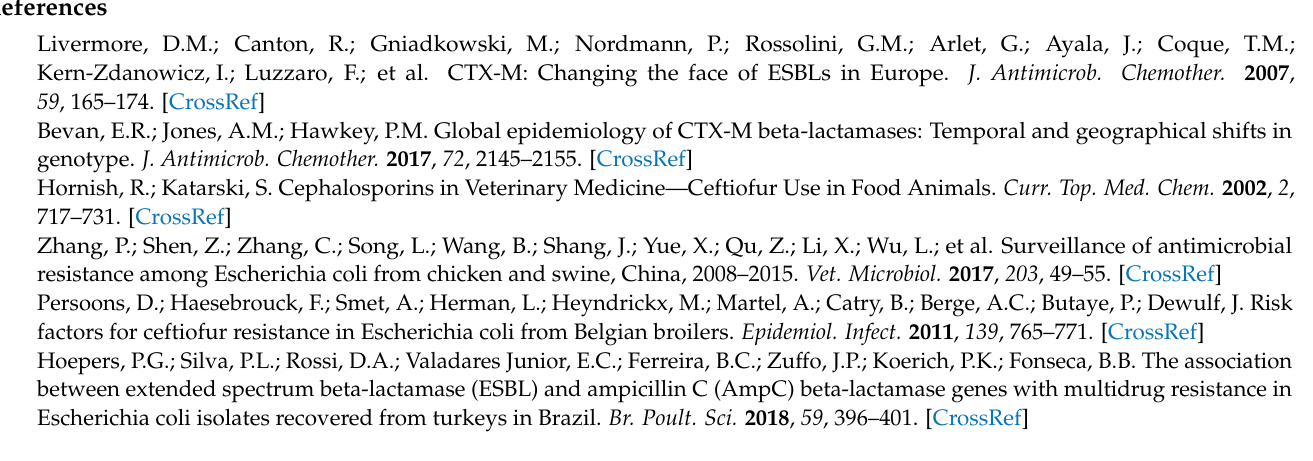
analysis. Table S1: the number of samples collected from chickens across five breeding periods. Table S2: the isolates collected from GenBank that possessed at least one of the ceftiofur resistance genes ( bla CTX-M-55 , bla CMY-2 and bla NDM-5 ). Table S3: the types of antimicrobials that were in use at the time of sample collection. Table S4: the molecular typing, MLST and MIC of the 84 ceftiofur-resistant E. coli isolates collected in current study. Table S5: background information of the 571 isolates that was selected from the 1145 E. coli isolates based on SNP to construct phylogenetic tree with 9 E. coli isolates in current